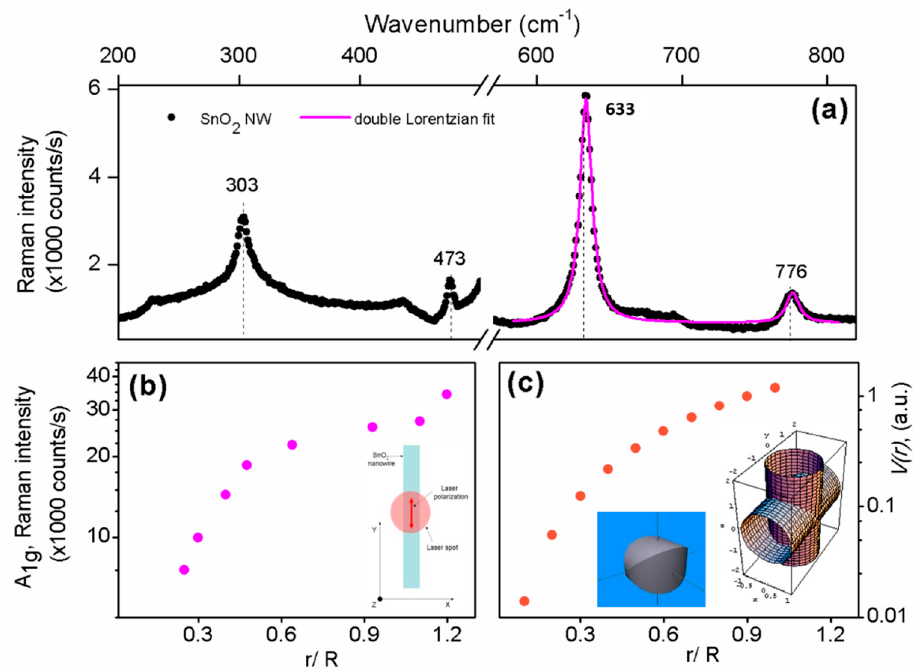
Figure 3. ( a ) Room temperature Raman spectrum of an individual and isolated straight SnO 2 NW, measured at λ = 632.8 nm with the laser spot focused on the central region of the NW. ( b ) Intensity of the A 1g Raman line of SnO 2 (obtained from Lorentzian fitting of the Raman band at 633 cm − 1 ) as a function of the r / R ratio between the radius of the NW (r) and the radius of the laser beam (R). ( c ) Calculated Raman active volume V(r) as a function of the r / R ratio. See Supporting Information for details on the calculation of the Raman active volume.